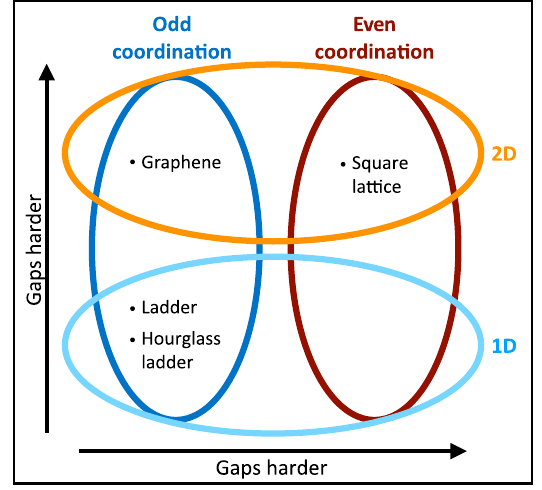
FIG. 6. Schematic diagram indicating which classes of lattices tend to exhibit large single-particle gaps at half-filling and where certain special examples fall. In general, higher-dimensional lat- tices tend to have fewer and smaller gaps due to their larger phase spaces. Lattices with odd coordination numbers often have very low densities of states near zero energy, making it